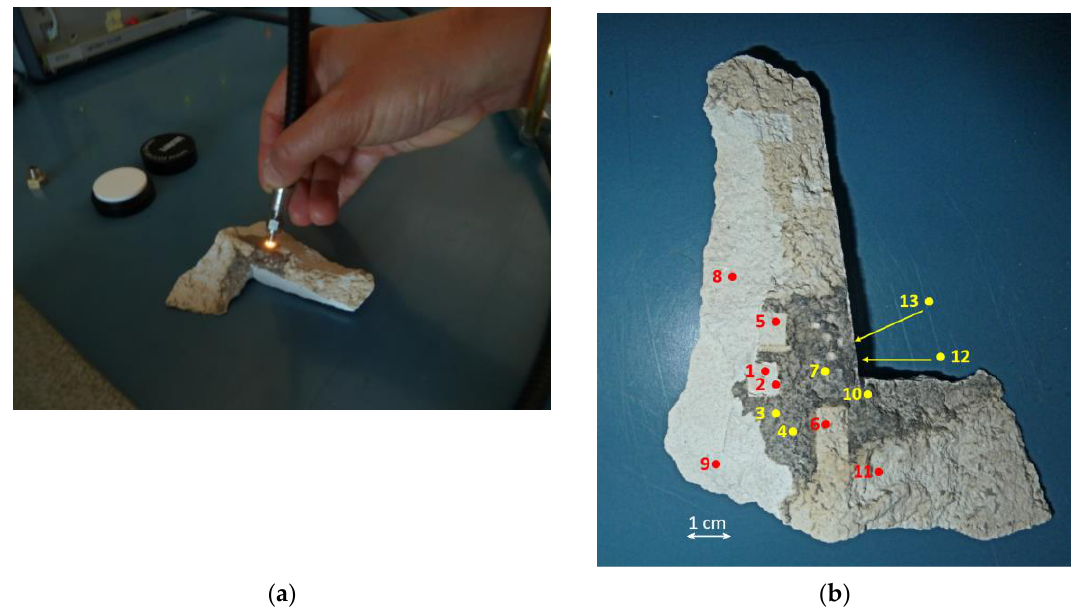
Figure 2. The optical fiber bundle illuminating the target and collecting the reflected radiation with an 8°/8° probe-head ( a ). The 13 spot areas where FORS measurements were performed, treatments a and b (red spots) and non-cleaned zones (yellow spots) ( b ).